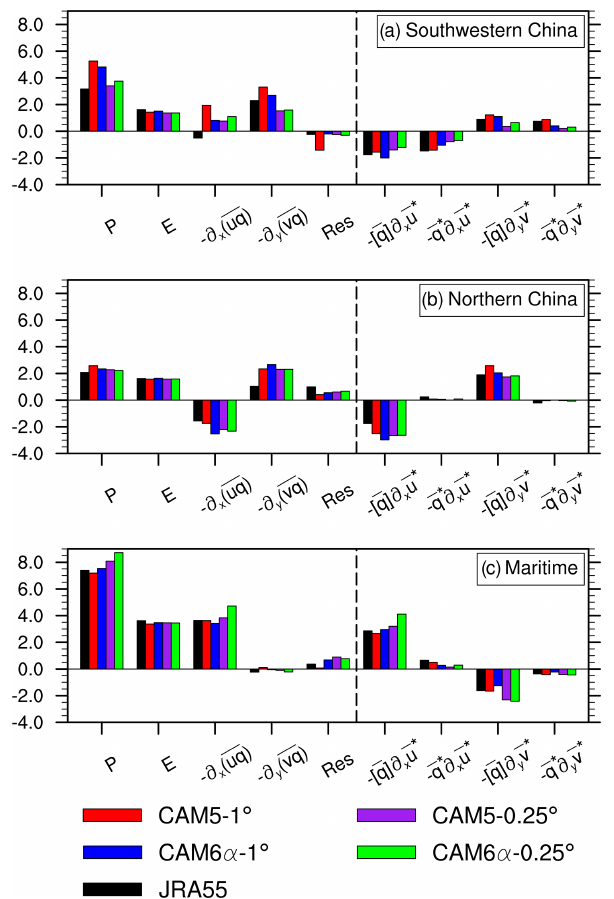
Figure 14. Moisture budget over (a) southwestern China, (b) north- ern China and (c) the Maritime Continent (see the boxes in Fig. 2c) for 1980–2004, including precipitation, evaporation, zonal and meridional moisture flux convergence, and the residual and (right to dashed line) major processes contributing to moisture flux con-